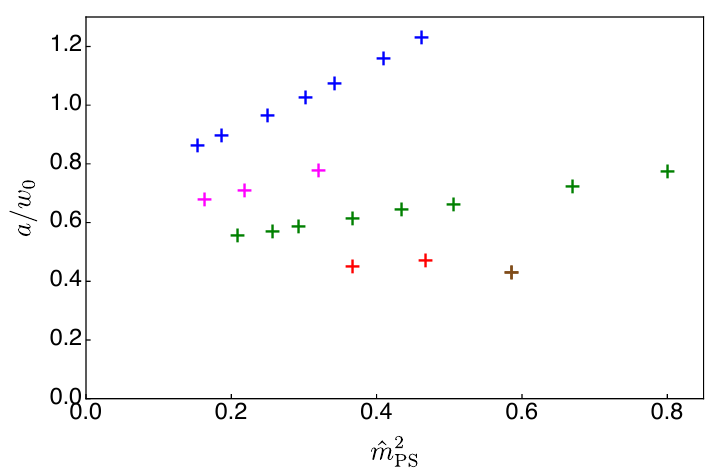
Figure 3. Inverse of the gradient (cid:13)ow scales w 0 with respect to the pseudoscalar meson mass squared, for data taken from table 1 and from table 6. Blue, purple, green, red and brown colours (top to bottom, approximately linear series) have (cid:12) = 6 : 9, 7 : 05, 7 : 2, 7 : 4 and 7 : 5,